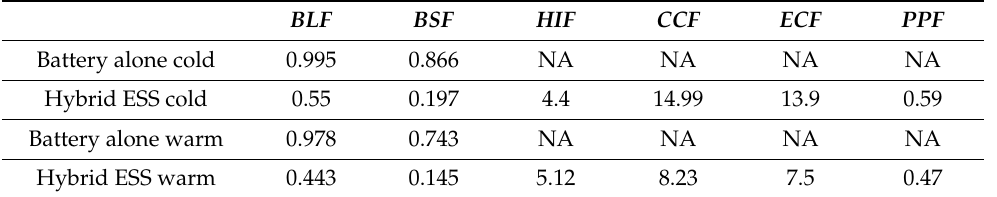
Table 2. Cranking aging